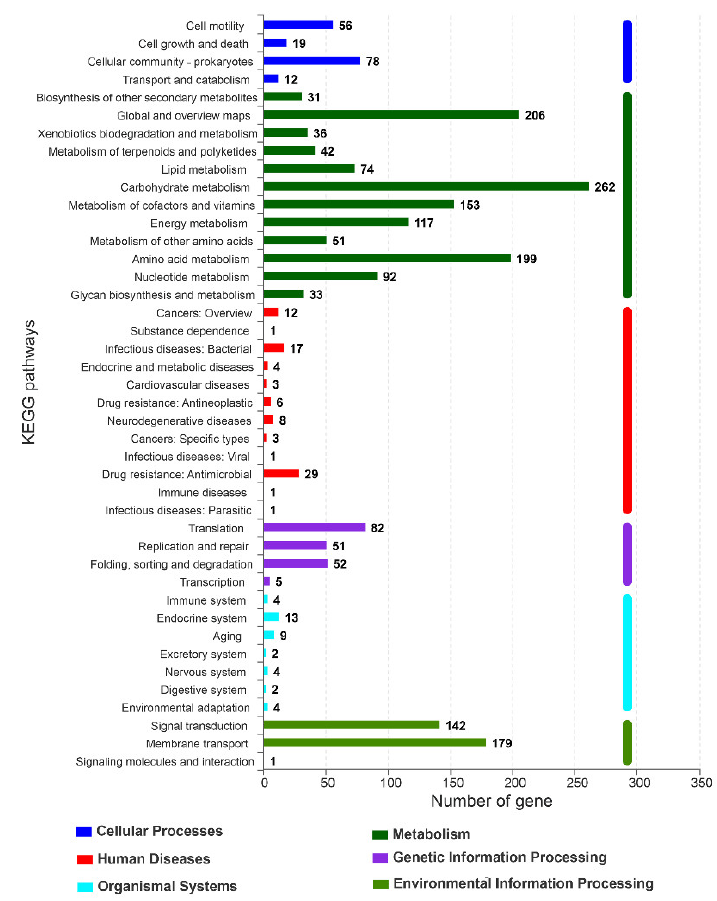
Figure 7. KEGG annotation classification of the B. subtilis A-5 genome.